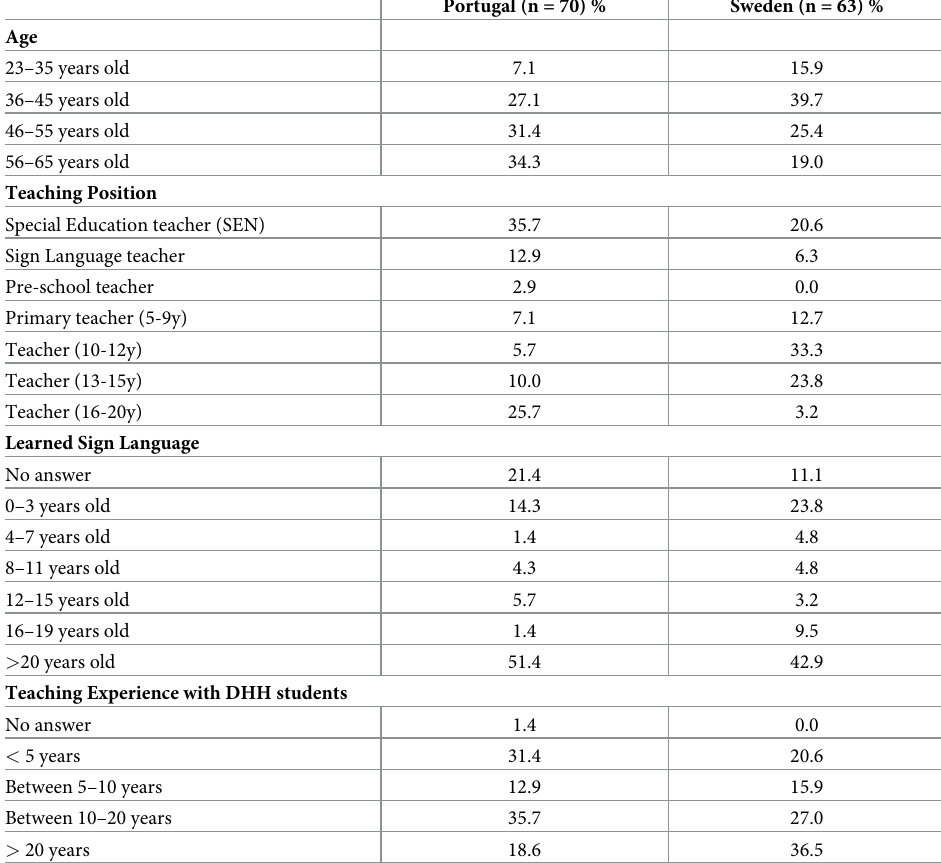
Table 1. Demographic data of Portuguese and Swedish teachers (N =